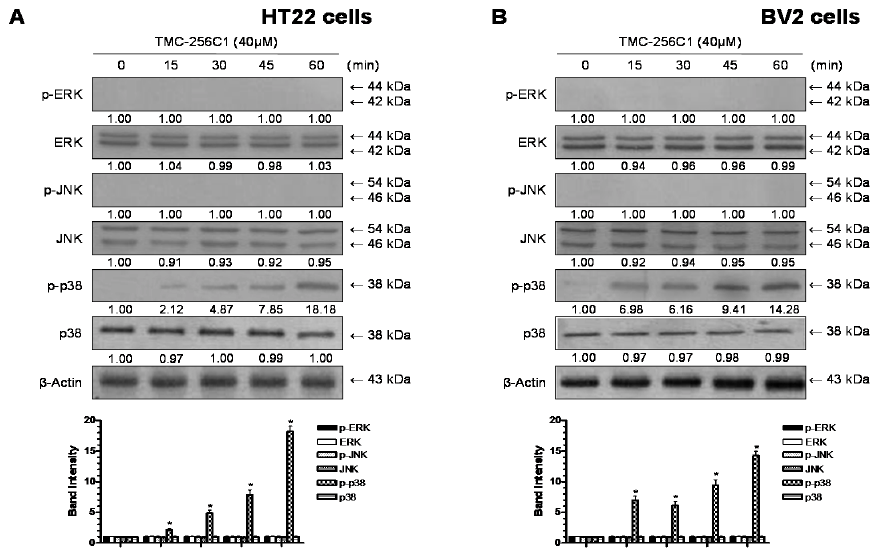
Figure 9. Effects of TMC-256C1 on extracellular signal-regulated kinases (ERK), c-Jun N-terminal kinase (JNK) and p38 mitogen-activated protein kinases (MAPK) expression in HT22 cells ( A ) and BV2 cells ( B ). Cells were treated with 40 μ M TMC-256C1 for the indicated times. Cell extracts were analyzed by Western blot with antibodies specific for phosphorylated ERK1/2 (p-ERK), phosphorylated JNK (p-JNK), or phosphorylated p38 (p-p38). Membranes were stripped and re-probed using antibodies with affinity for both the phosphorylated and non-phosphorylated forms of each MAPK as a control, and the representative blots of three independent experiments are shown. Band intensity was quantified by densitometry and normalized to β -actin, and the normalized values are presented at the bottom of each band. The data shown, representative of three independent experiments, are the mean values of three experiments ± SD. * p < 0.05 compared to the group treated with LPS.